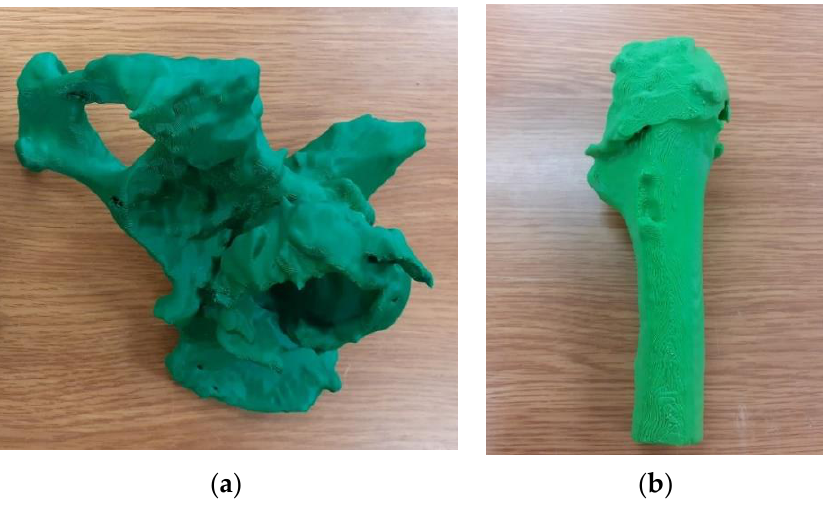
Figure 13. Model of the anatomical structure: ( a ) Part of the bone of the pelvis with the bone cement, and ( b ) the upper part of the femoral bone.